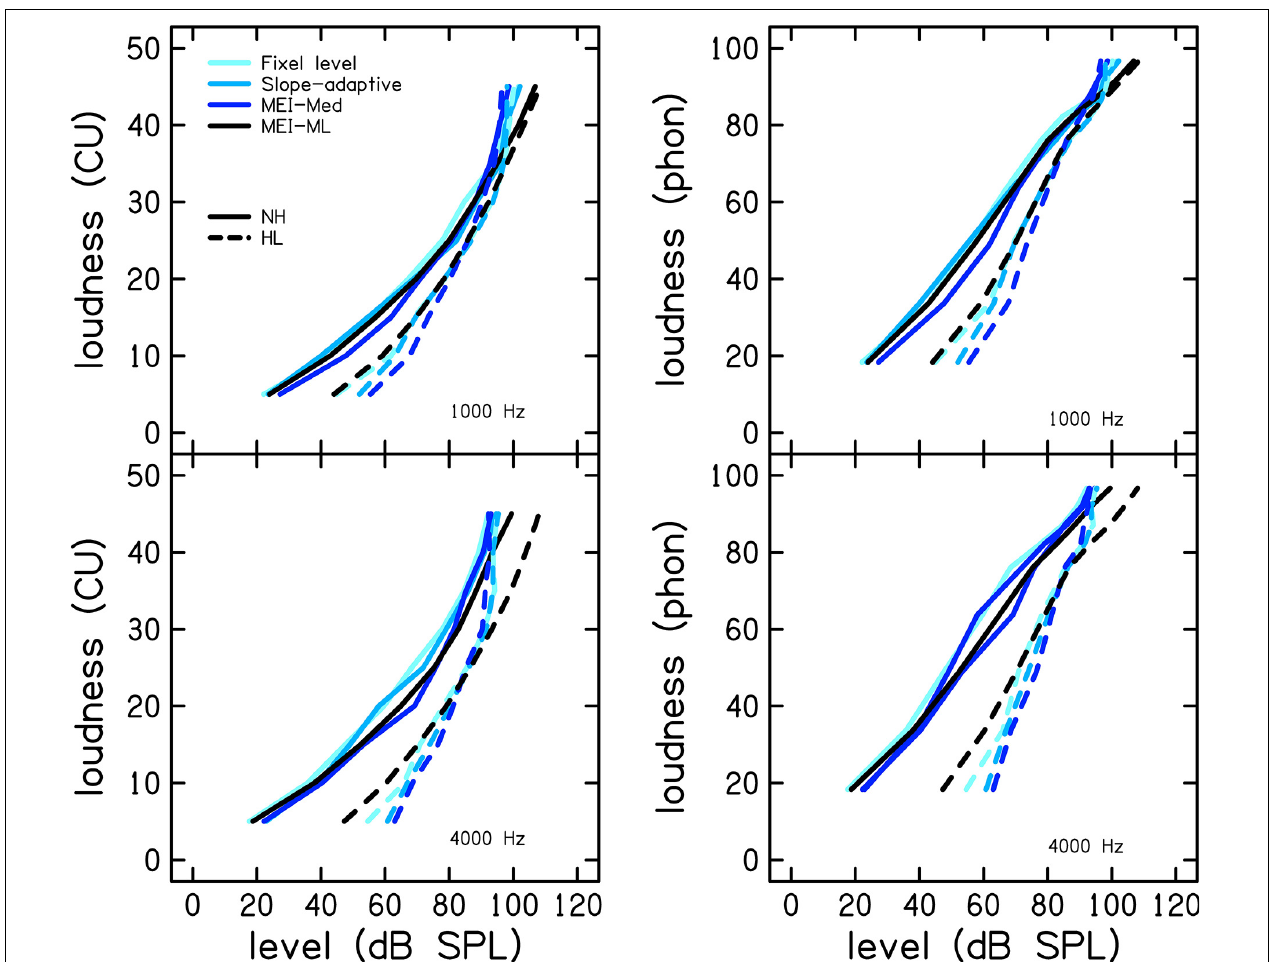
FIGURE 4 | Mean CLS functions for each of the procedures at 1 (top row) and 4 kHz (bottom row) for the group of participants with normal hearing (NH; solid lines) and the group with hearing loss (HL; dashed lines). The left column shows loudness in categorical units and the right column shows loudness level in phons. CLS functions were calculated based on the mean sound pressure level (SPL) per category